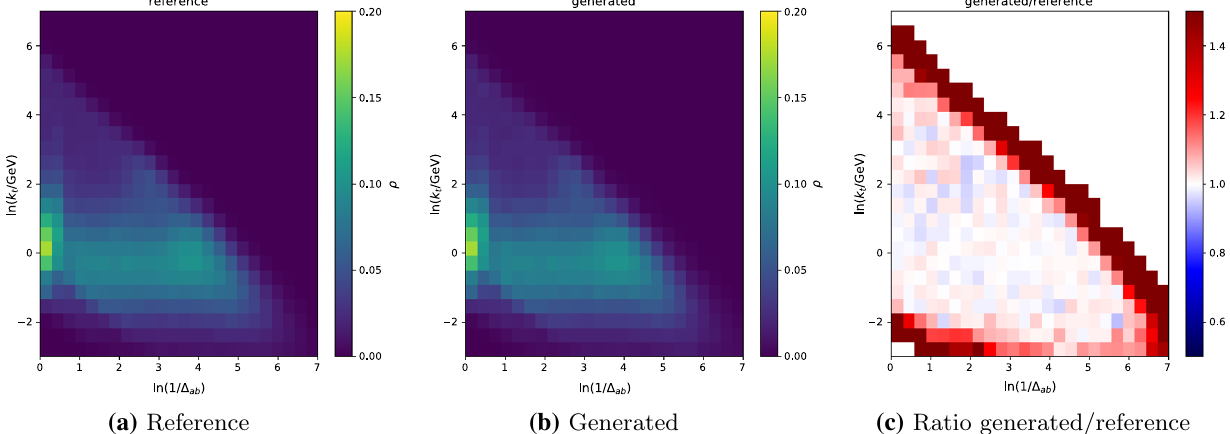
Fig. 7 Average Lund jet plane density for a the reference sample and b a data set generated by the gLund model. c The ratio between these two